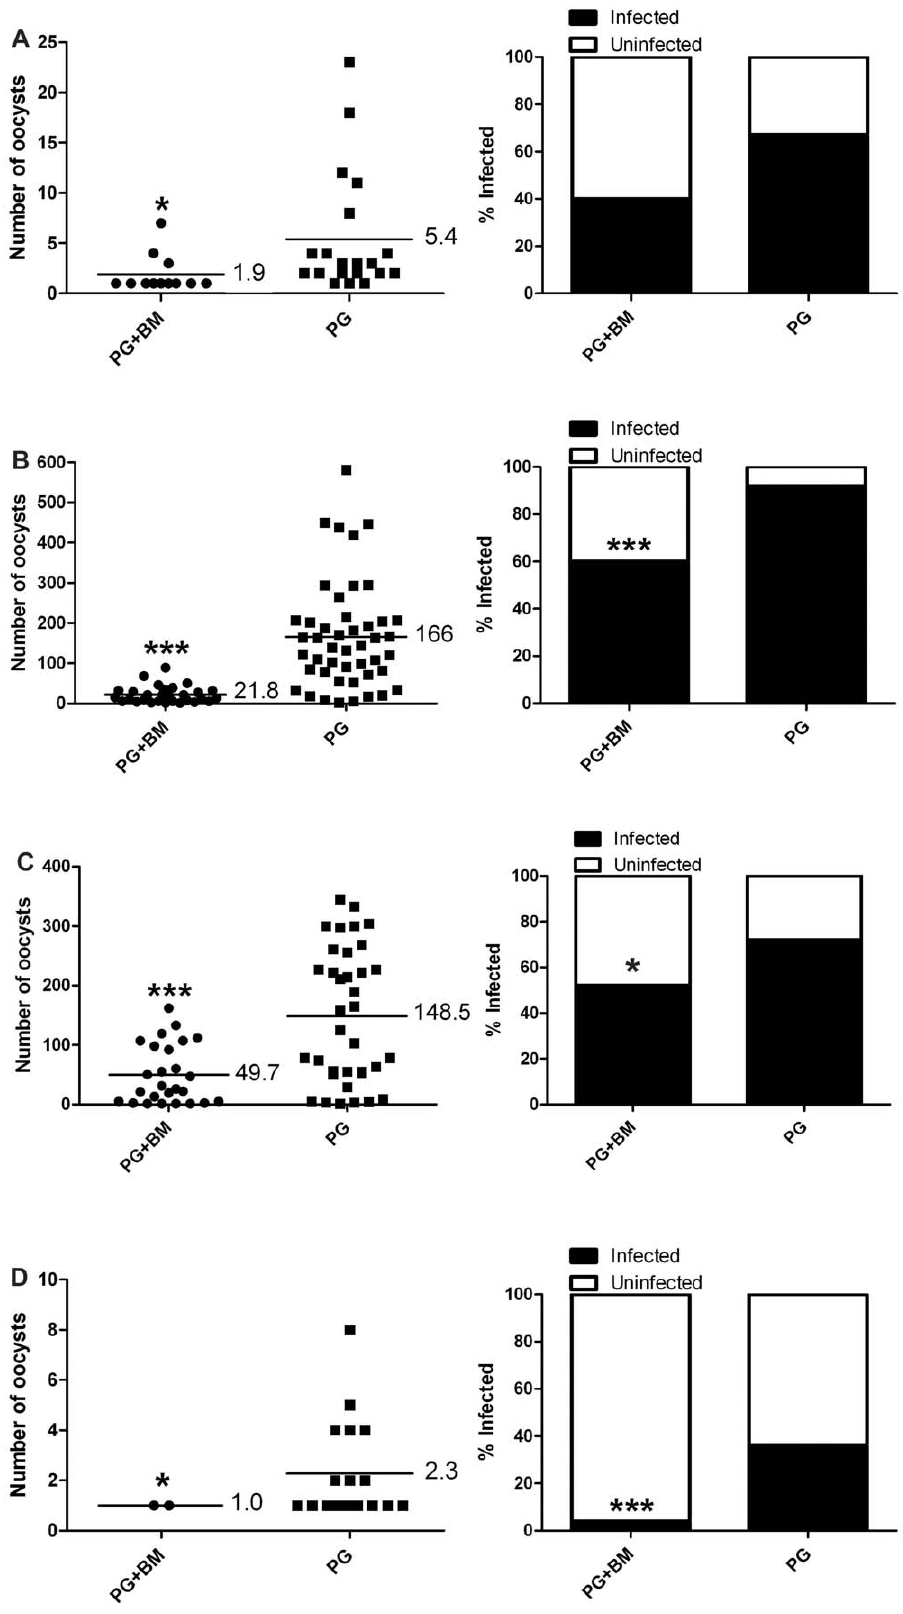
Figure 1. Plasmodium infection in Ar.subalbatus that concurrently ingested P.gallinaceum and B.malayi. Mosquitoes that fed on blood containing P. gallinaceum alone served as controls. For all, the left panel indicates infection intensity where points indicate the absolute value of